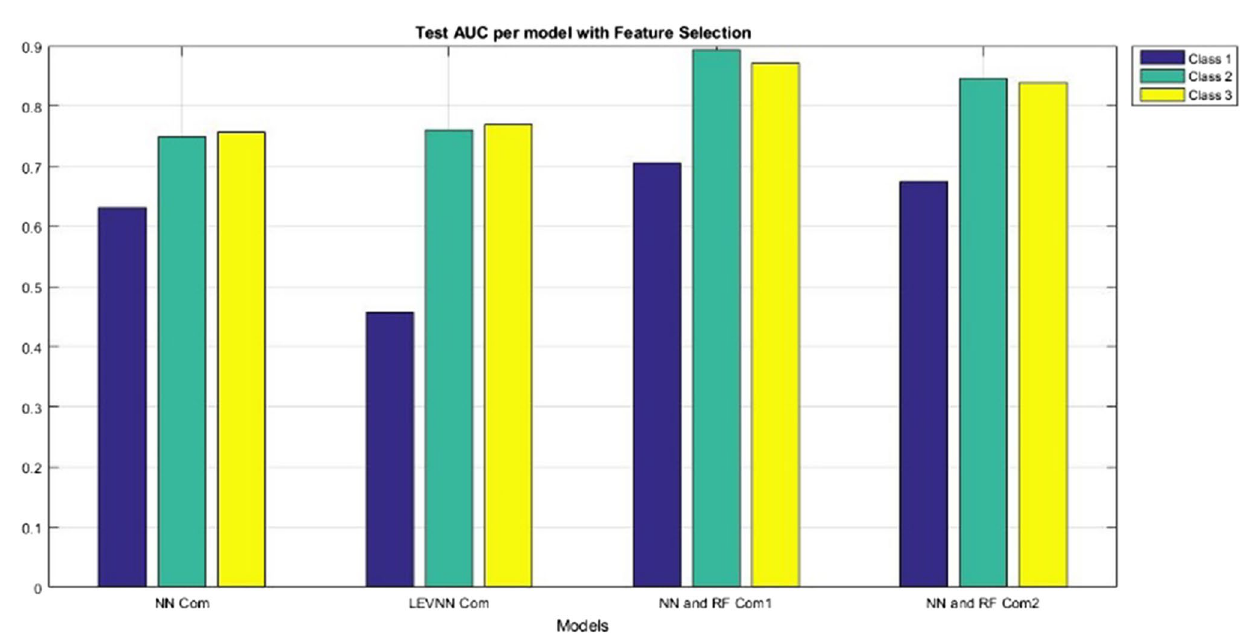
Fig. 16 AUC for the combined classifier (testing)